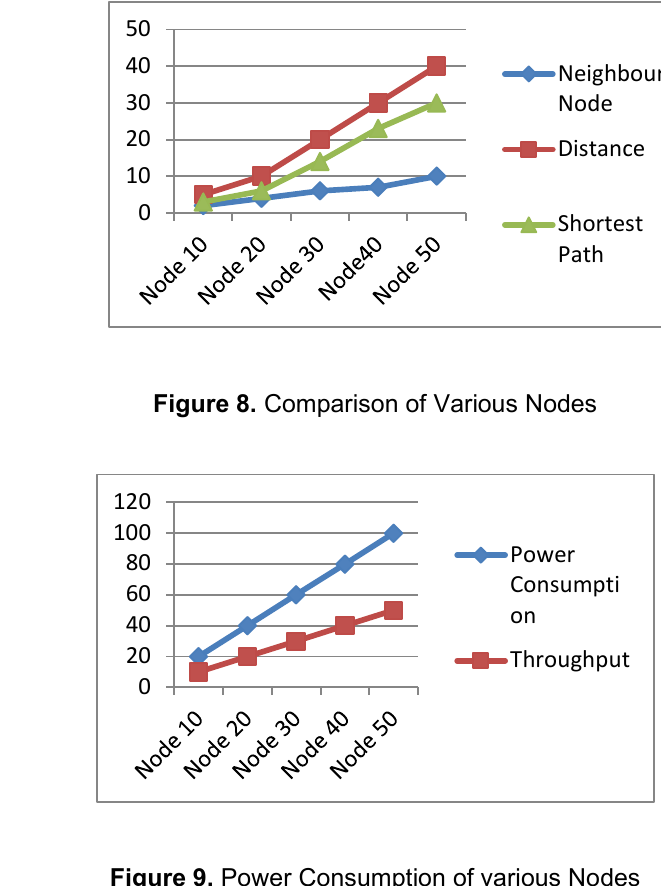
Figure 9. Power Consumption of various Nodes